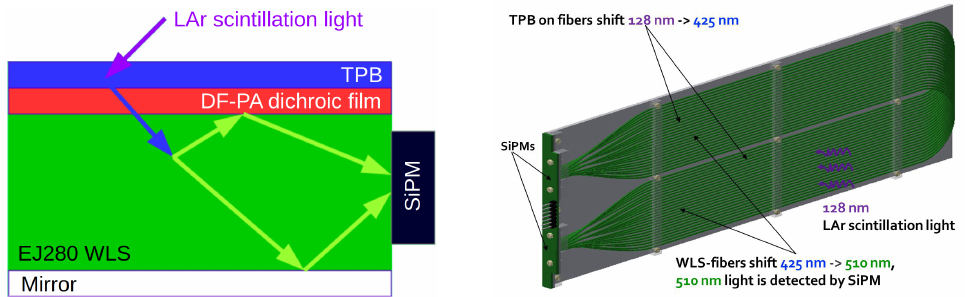
Figure 9. Two approaches to light detection: ArCLight ( left ) and LCM ( right ). The LCM is a frame cantilevered by a PVC plate that holds WLS fibers which are bent into two bundles. Each bundle is optically coupled to an SiPM light sensor as shown on the right side of Figure 9. The fibers are grouped and held by spacer bars with holes which are fixed on the PVC plate by means of polycarbonate screws to provide good matching of the thermal contraction. The PVC plate with the WLS fibers is coated with TPB that re-emits absorbed VUV light in the violet. The violet light is shifted inside multi-cladding ( ∅ = 1.2 mm) Kuraray Y-11 fibers to green light ( 510 nm). That green light is trapped ∼